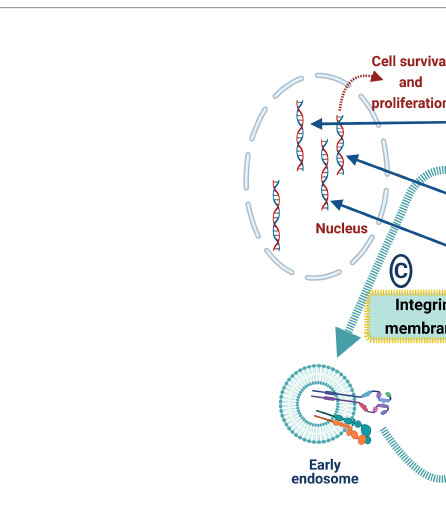
FIGURE 4 | ECM proteins and integrins regulate EGFR signaling pathways in lung cancer. The crosstalk between EGFR and integrins includes many signaling pathways: (A) ligand-independent pathway, where integrins can biochemically bind to EGFR leading to its activation. EGFR can interact with integrins via forming a multimeric complex (Src, FAK, and the adaptor protein p130Cas), leading to cell survival and proliferation, (B) ligand-dependent pathway, where integrin clustering enhances EGFR signaling cascades upon EGFR ligand binding, resulting in enhancing Akt, ERK, and Ras signaling pathways, and (C) integrin traf fi cking controls the membrane expression of EGFR. Blue arrows for stimulation; dashed red arrows for cellular effect, and red “ T ” sign for